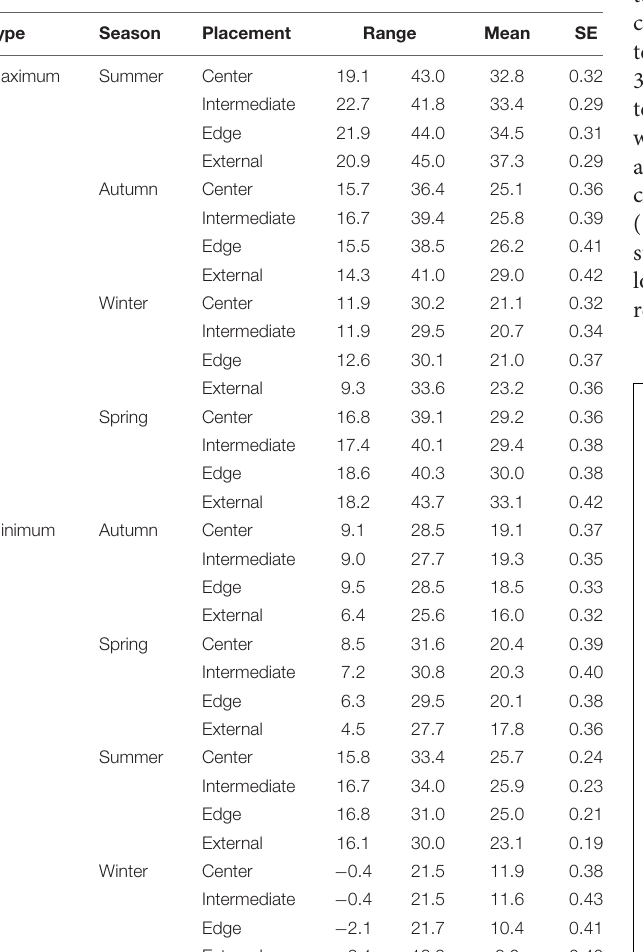
TABLE 1 | Seasonal temperature readings including the minimum, maximum, mean, and standard error for each logger placement for maximum and minimum comparisons.